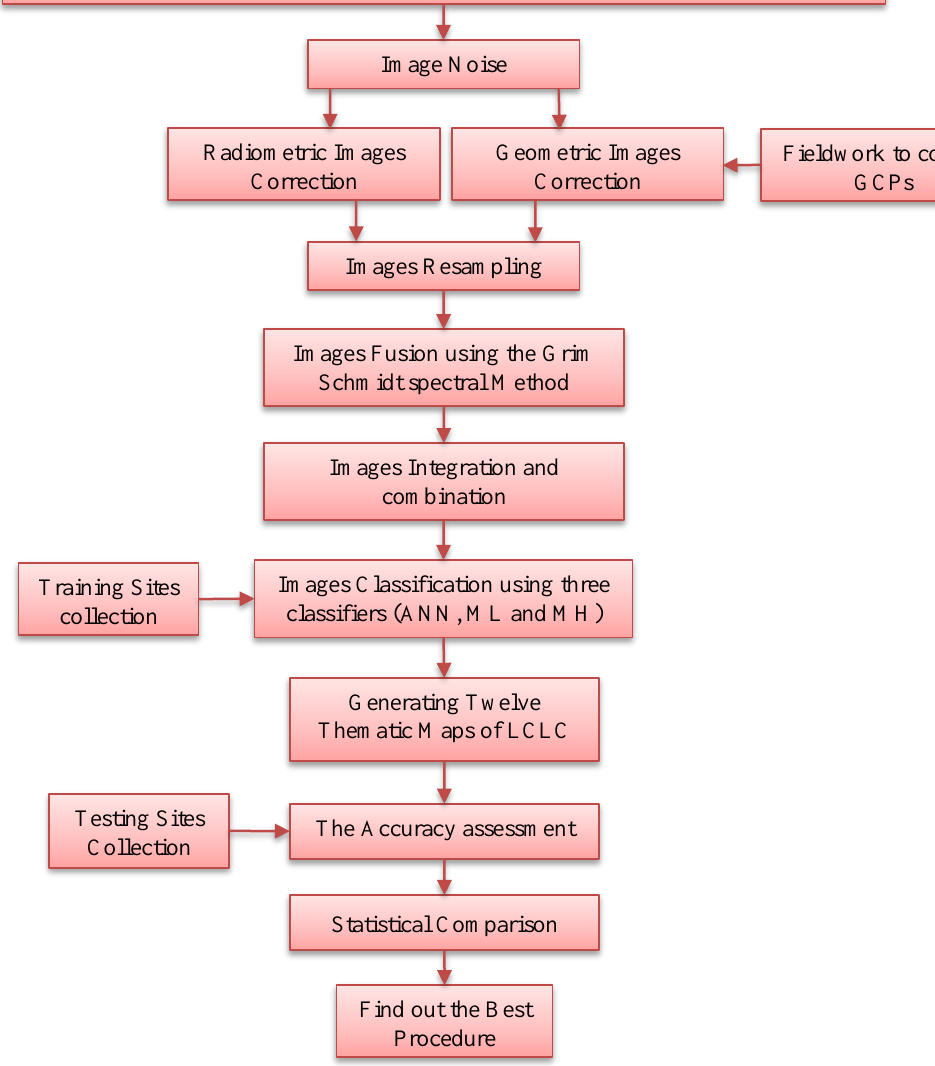
Figure 1. Flowchart of the adopted methodology